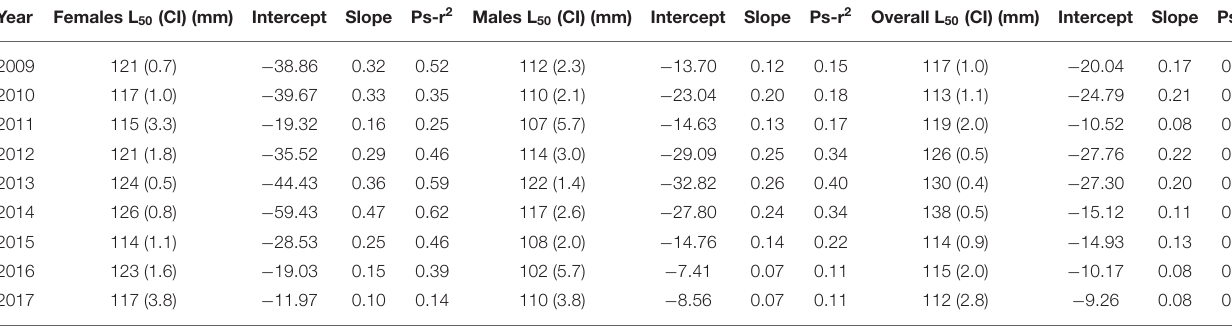
TABLE 2 | Length at maturity (L 50 ) estimations for separated genders, for each